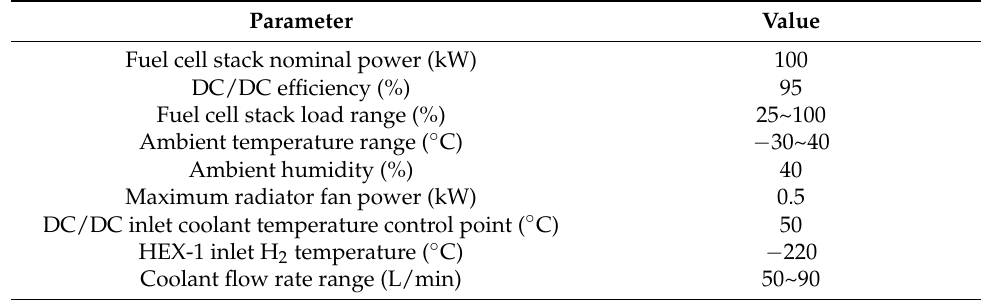
Table 1. Parameters and boundary conditions of cold energy utilization system